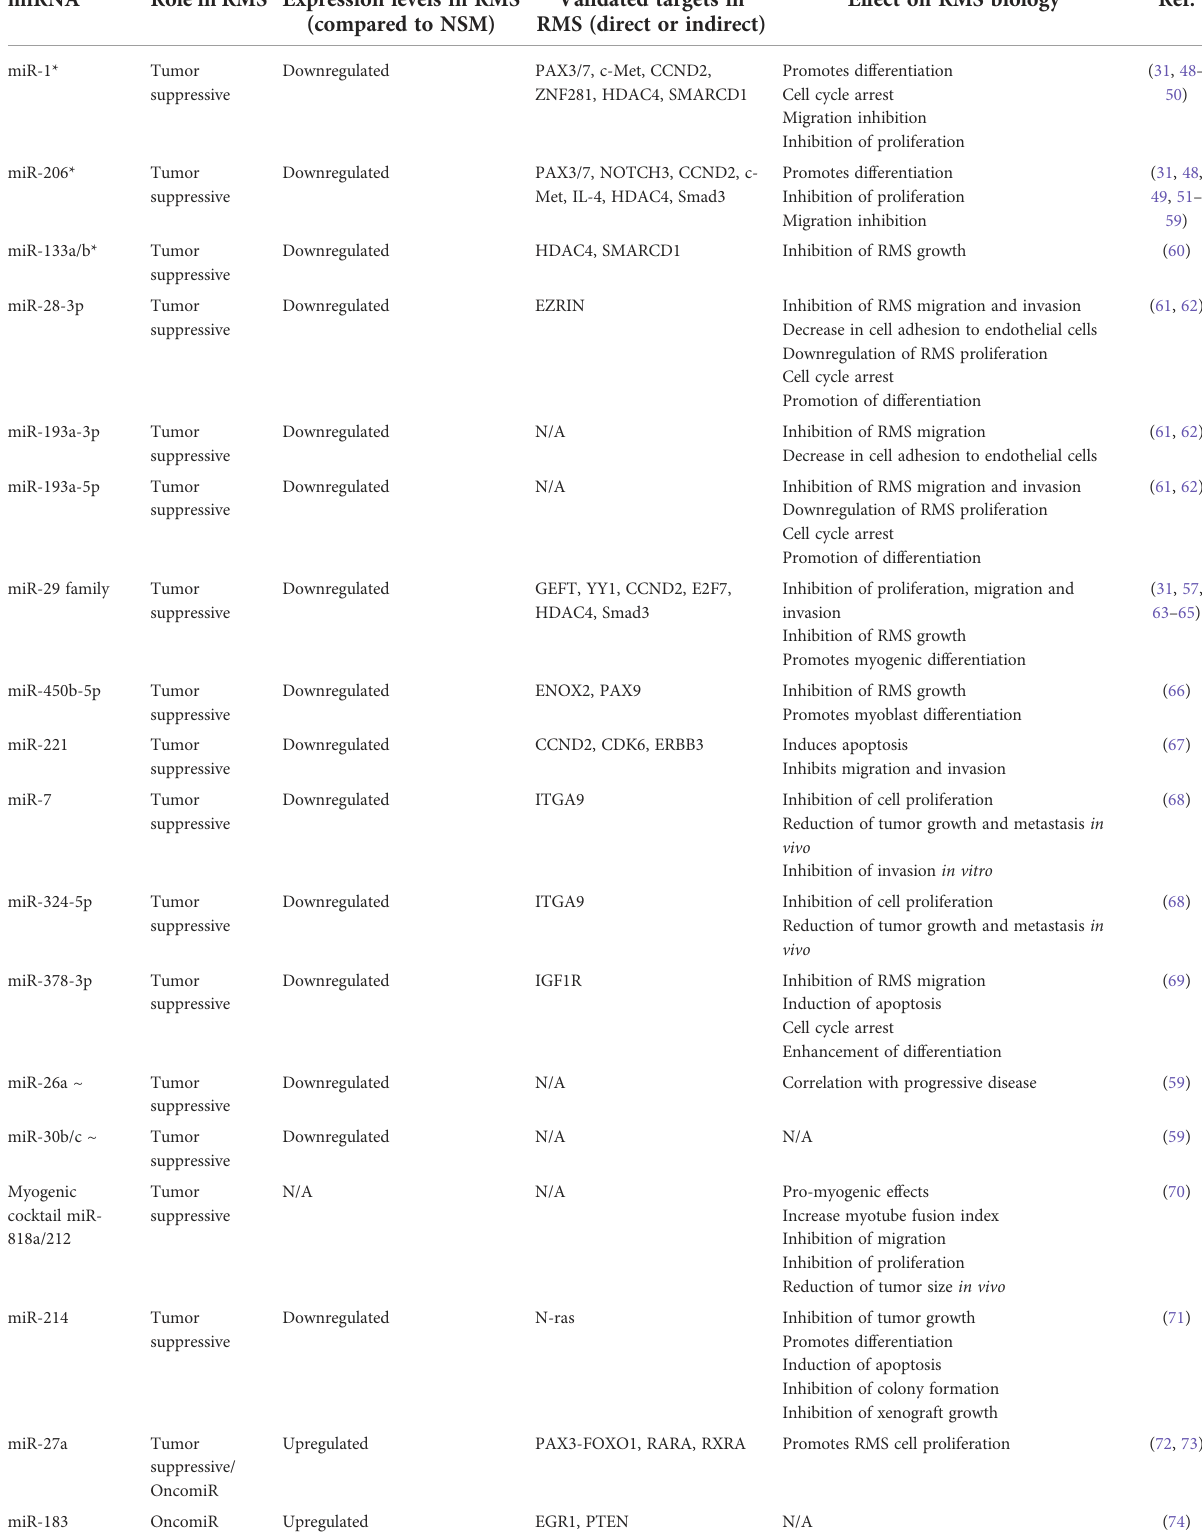
TABLE 1 miRNA players in rhabdomyosarcoma. miRNA